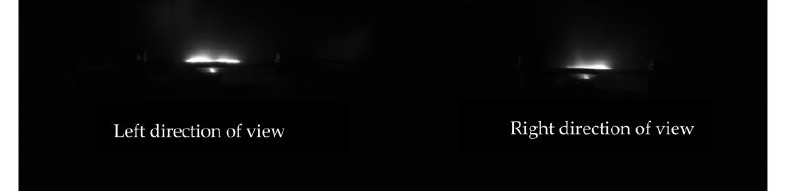
Figure 7. Recorded image of the ignition from the PJP without magnetic nozzle with 1 µs time delay. On the left side of the camera chip, the left direction of view is mapped, and on the right side, the corresponding right direction of view.